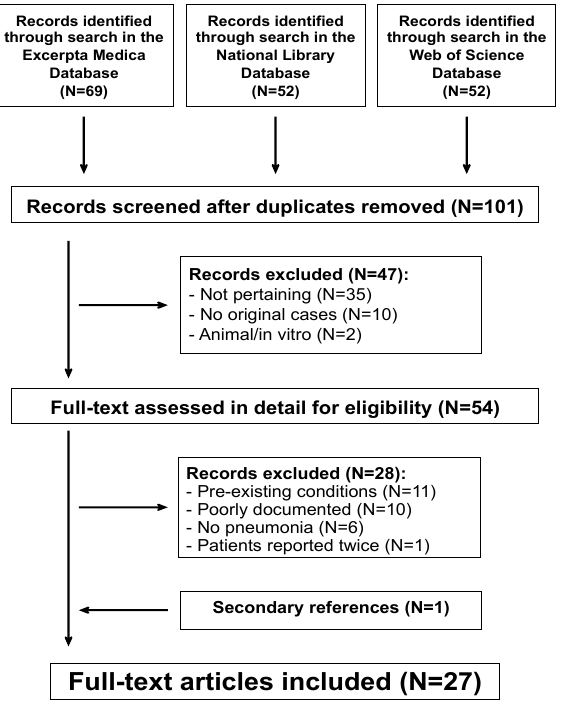
Figure 1. Acute pancreatitis associated with atypical bacterial pneumonia. Flowchart of the literature search.